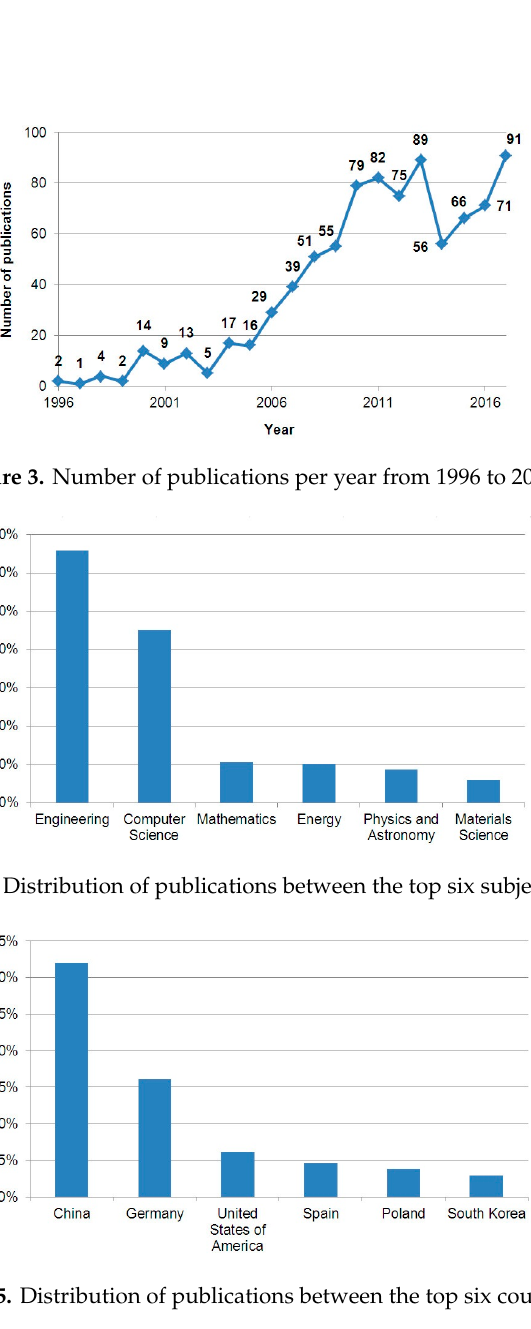
Figure 5. Distribution of publications between the top six countries.